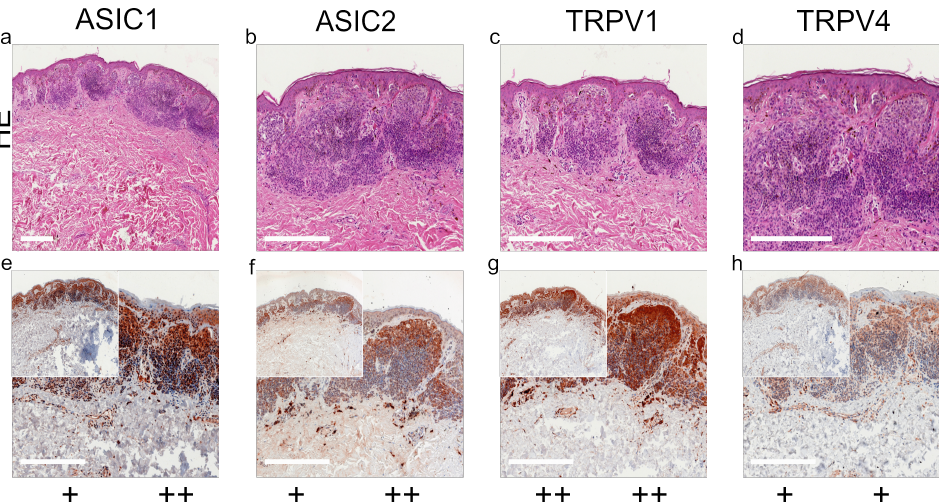
Figure 3. Immunohistochemistry of NCN. ( a – d ) H&E staining, ( e – h ) immunohistochemical staining, inserted smaller pictures show an overview. Scale bars represent 200 µm. ( a – h ) Patient 14. This NCN shows weak, positive expressions of ASIC1, ASIC2 and TRPV4 on the epidermal sections. TRPV1 is expressed strongly in the epidermis. Regarding the dermal area, ASIC1, ASIC2 and TRPV1 show strong expressions, whereas TRPV4 reveals a weak staining. It has to be mentioned that this NCN shows a decreasing expression in deeper dermal tumor tissue for all channels. For more stainings of other NCN, see Supplementary Figures S8–S11.